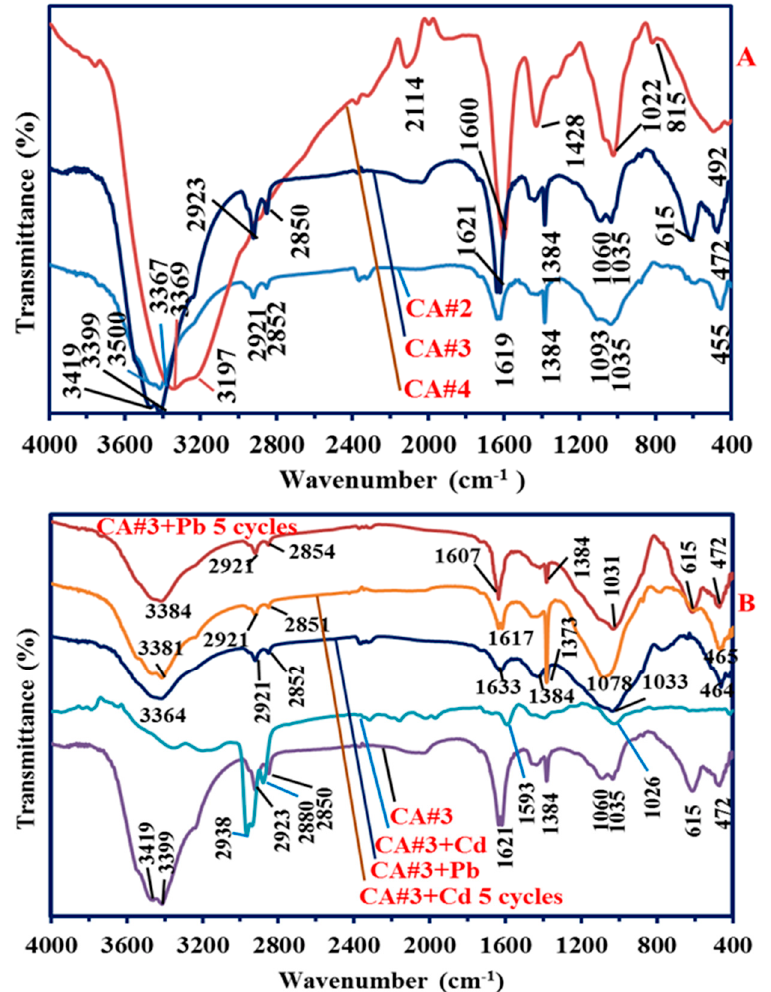
Figure 1. FTIR spectra of CA#2, CA#3 and CA#4 ( A ) and CA#3, after loading with Cd and Pb, and after five cycles of sorption desorption ( B ) (wavenumber: 4000–400 (cm − 1 )).